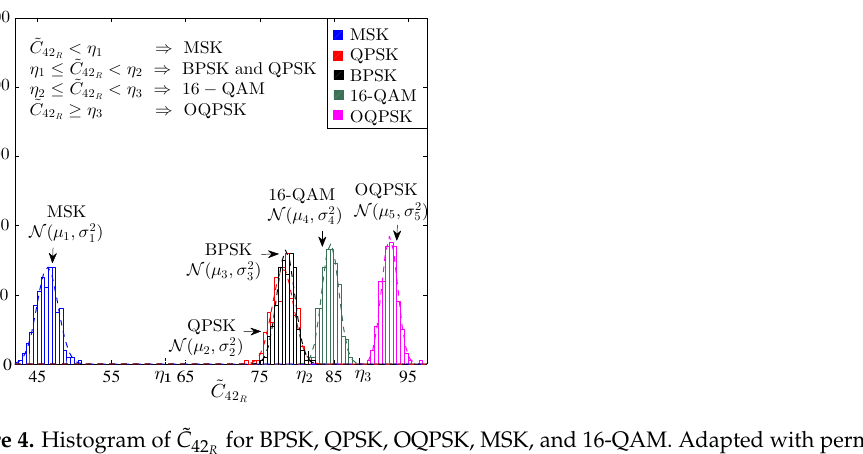
Figure 4. Histogram of ˜ C 42 for BPSK, QPSK, OQPSK, MSK, and 16-QAM. Adapted with permission R from Ref. [63]. Copyright 2021 IEEE.